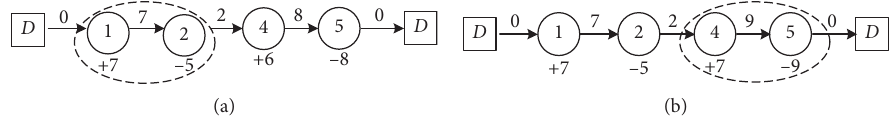
Figure 3: Neighbor solutions after applying the adjustment operator in one pickup-delivery pair. (a) Adjustment of the loading and unloading quantities between stations in the first pickup-delivery pair. (b) Adjustment of the loading and unloading quantities between stations in the second pickup-delivery pair.